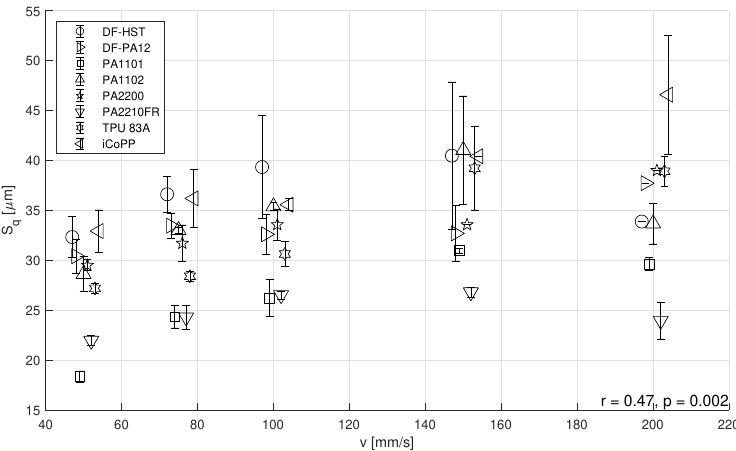
Figure 5. Surface roughness ( S q ) versus recoating speed per